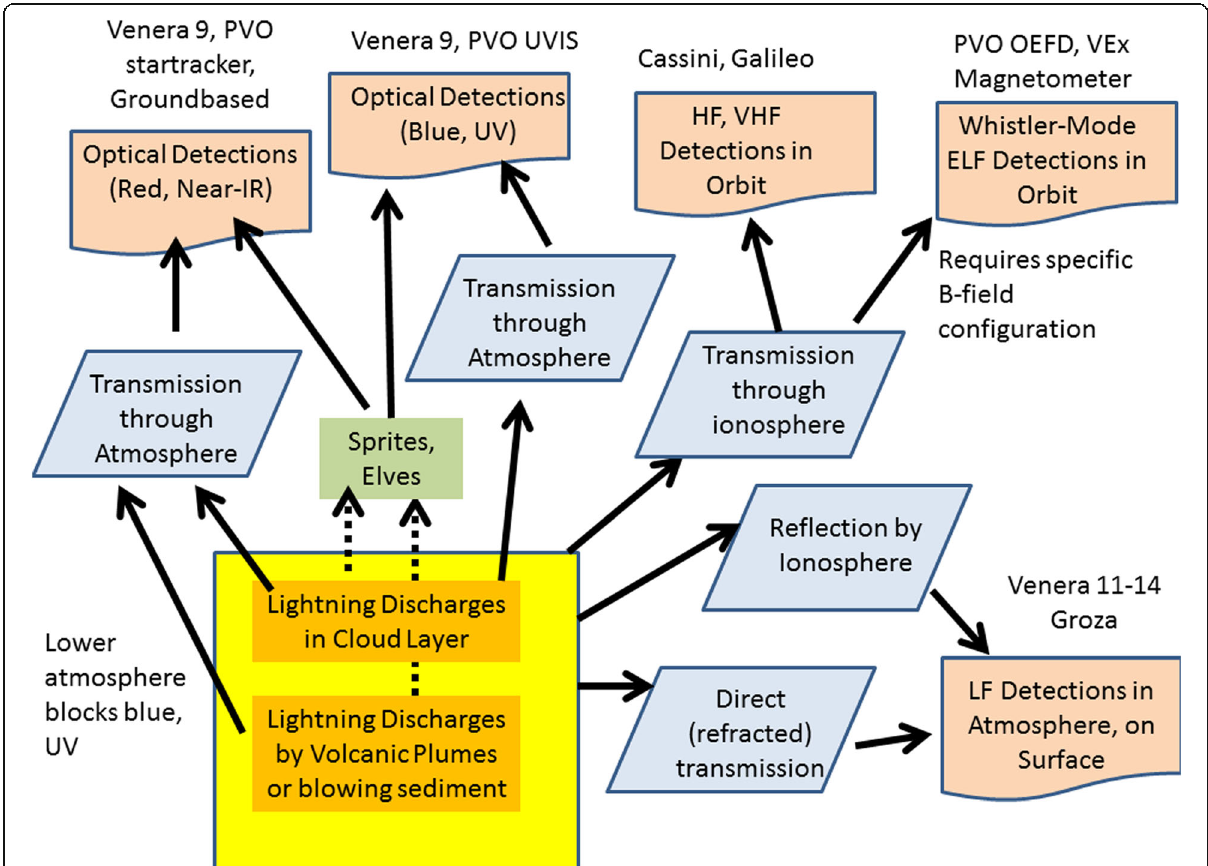
Fig. 3 A schematic of lightning sources and detection mechanisms, noting that detections rely on signal propagation mechanisms that may not be effective for all